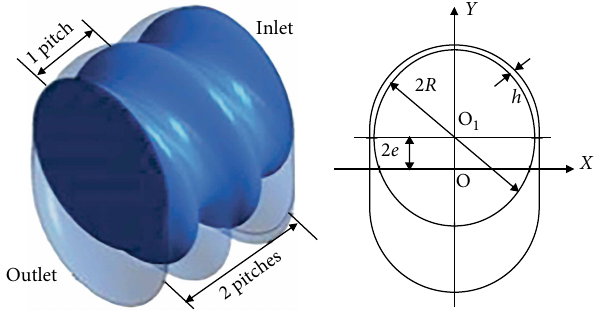
Figure 2: Geometry model of rotor and flow domain in melt conveying section.